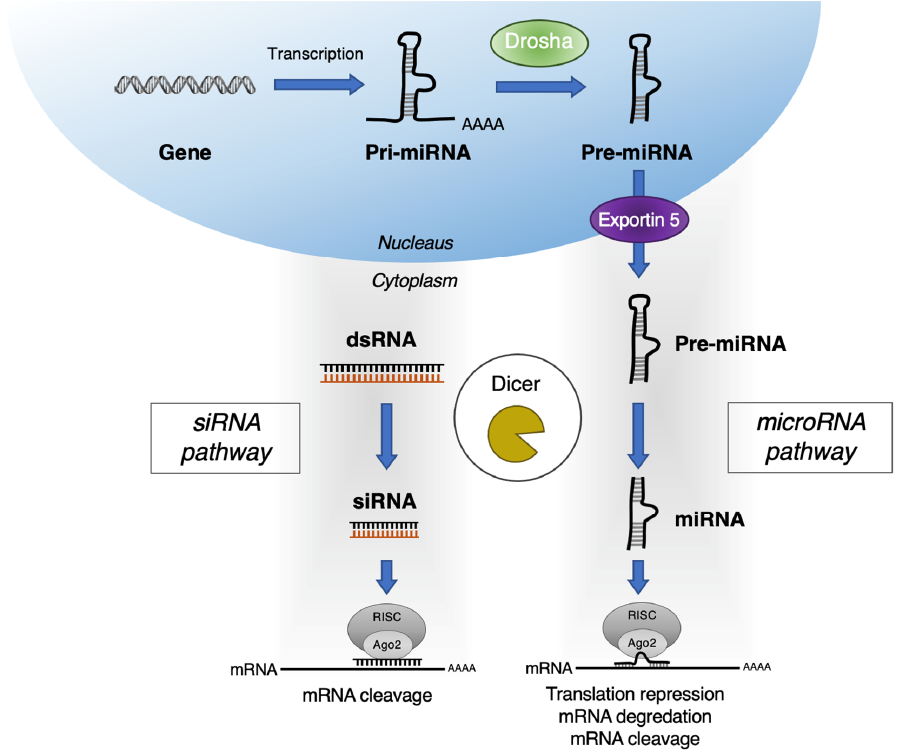
Figure 1. Gene silencing mechanism of siRNA and miRNA of